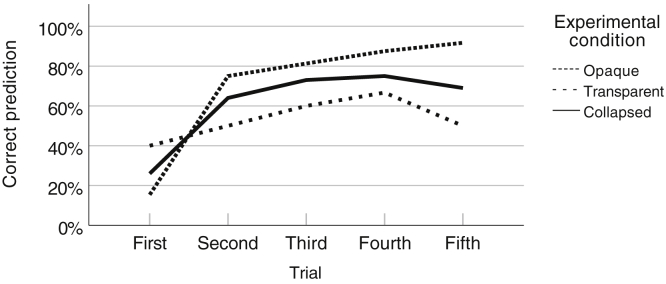
Endogenous Facilitation ExperimentThe proportion of correct predictions across consecutive test trials.